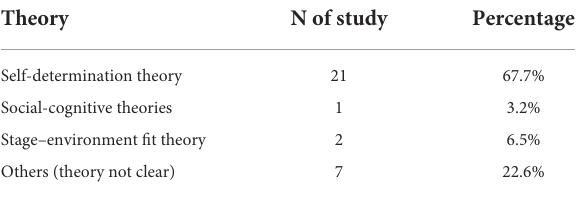
TABLE 8 Theories used in identified studies.